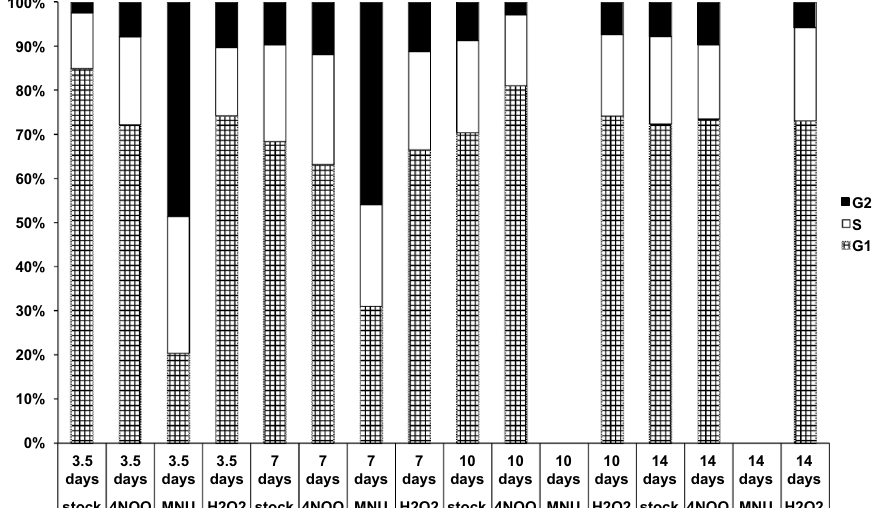
Figure 2. Cell growth ( a ) and flow cytometric analysis of the cell cycle distribution ( b ) of GM1899A cells propagated 1:3 every 3.5 days over a two-week period in the absence (untreated) or presence of 20 ng/ml 4NQO, 10 μM H 2 O 2 , or 20 μg/ml MNU. Relative cell number for each time point was calculated as total cell number for that point divided by total cell number at day 0 and plotted on a logarithmic scale. Cell cycle distributions were determined by propidium iodide-based DNA content analysis. Results are based on one